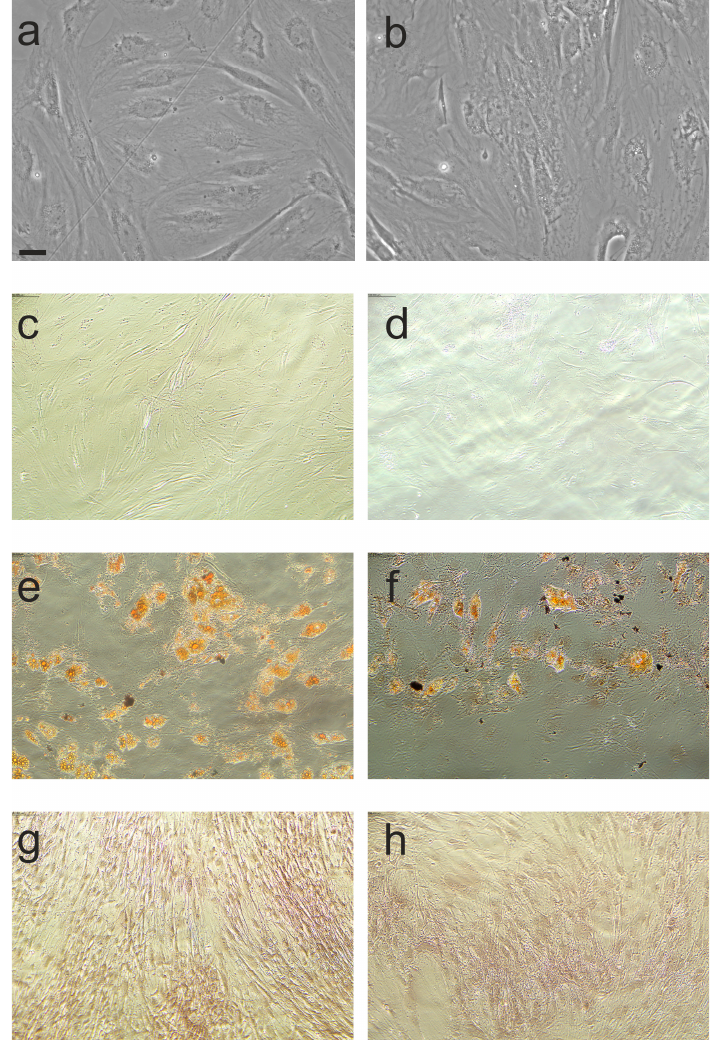
Figure 7. IStemRewind isolated ADSCs retain their differentiation potential after 1 month cryopreservation. ( a – f ) Representative bright field images of freshly isolated ( a , c , e , g ) and 1 month cryopreserved, thawed ( b , d , f , h ) MSCs isolated using IStemRewind. Scale bar, 100 µm. Cells were cultured in expansion medium ( a – d ), or in adipogenesis ( e , f ) and osteogenesis ( g , h ) inductive conditions. Adipocytes were stained with Oil Red O ( e , f ) and osteoblasts were stained using Alzarin Red S ( g , h ).